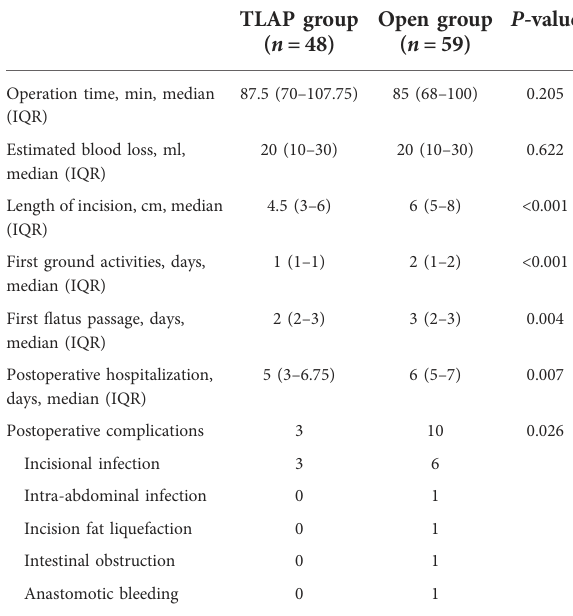
TABLE 2 Surgical and postoperative parameters of patients. TABLE 1 Demographic and baseline characteristics of